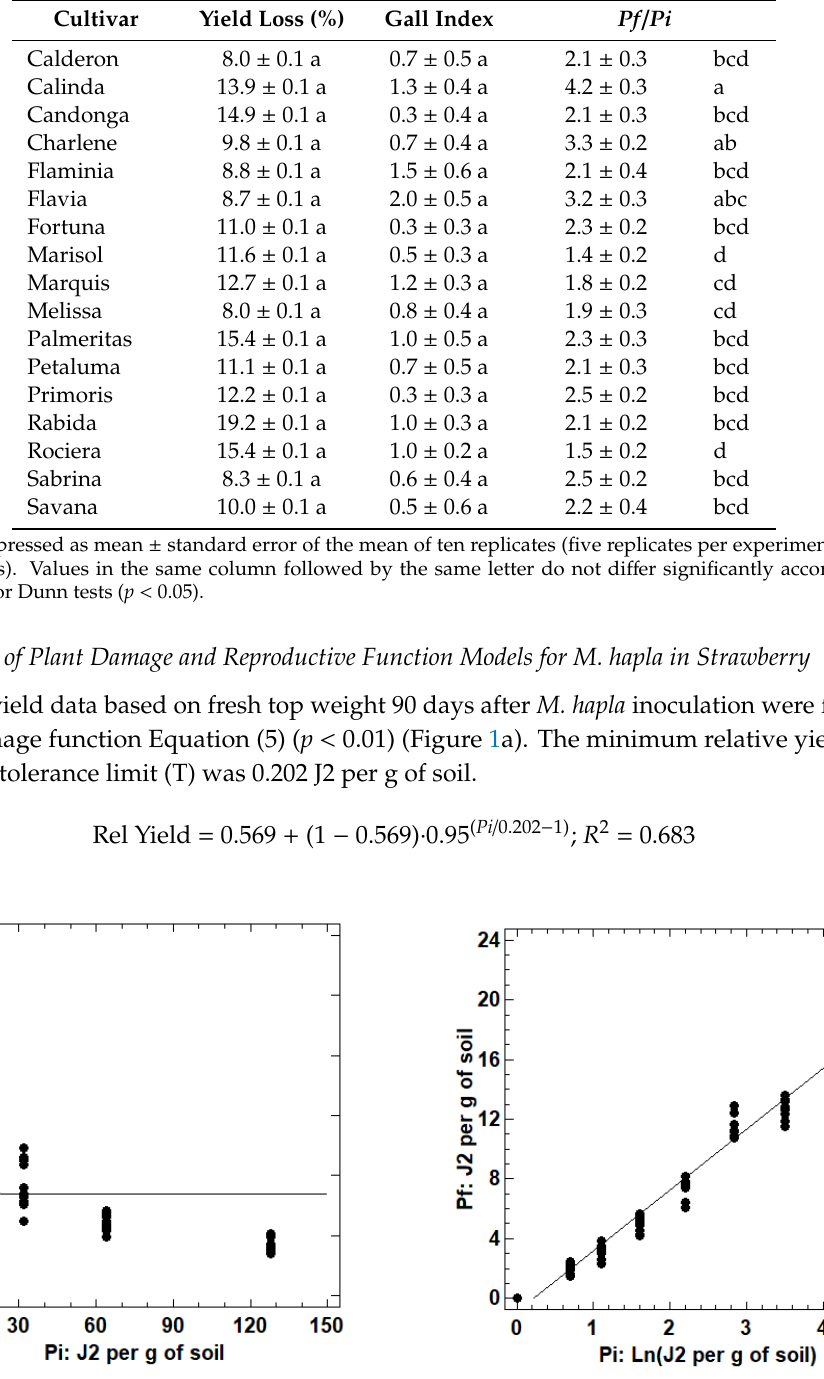
Table 4. Relative yield losses, root gall indices, and multiplication rates ( Pf / Pi ) of Meloidogyne hapla on seventeen strawberry cultivars, at 70 days post inoculation of one juvenile per g of soil in pot experiments in a growth chamber.